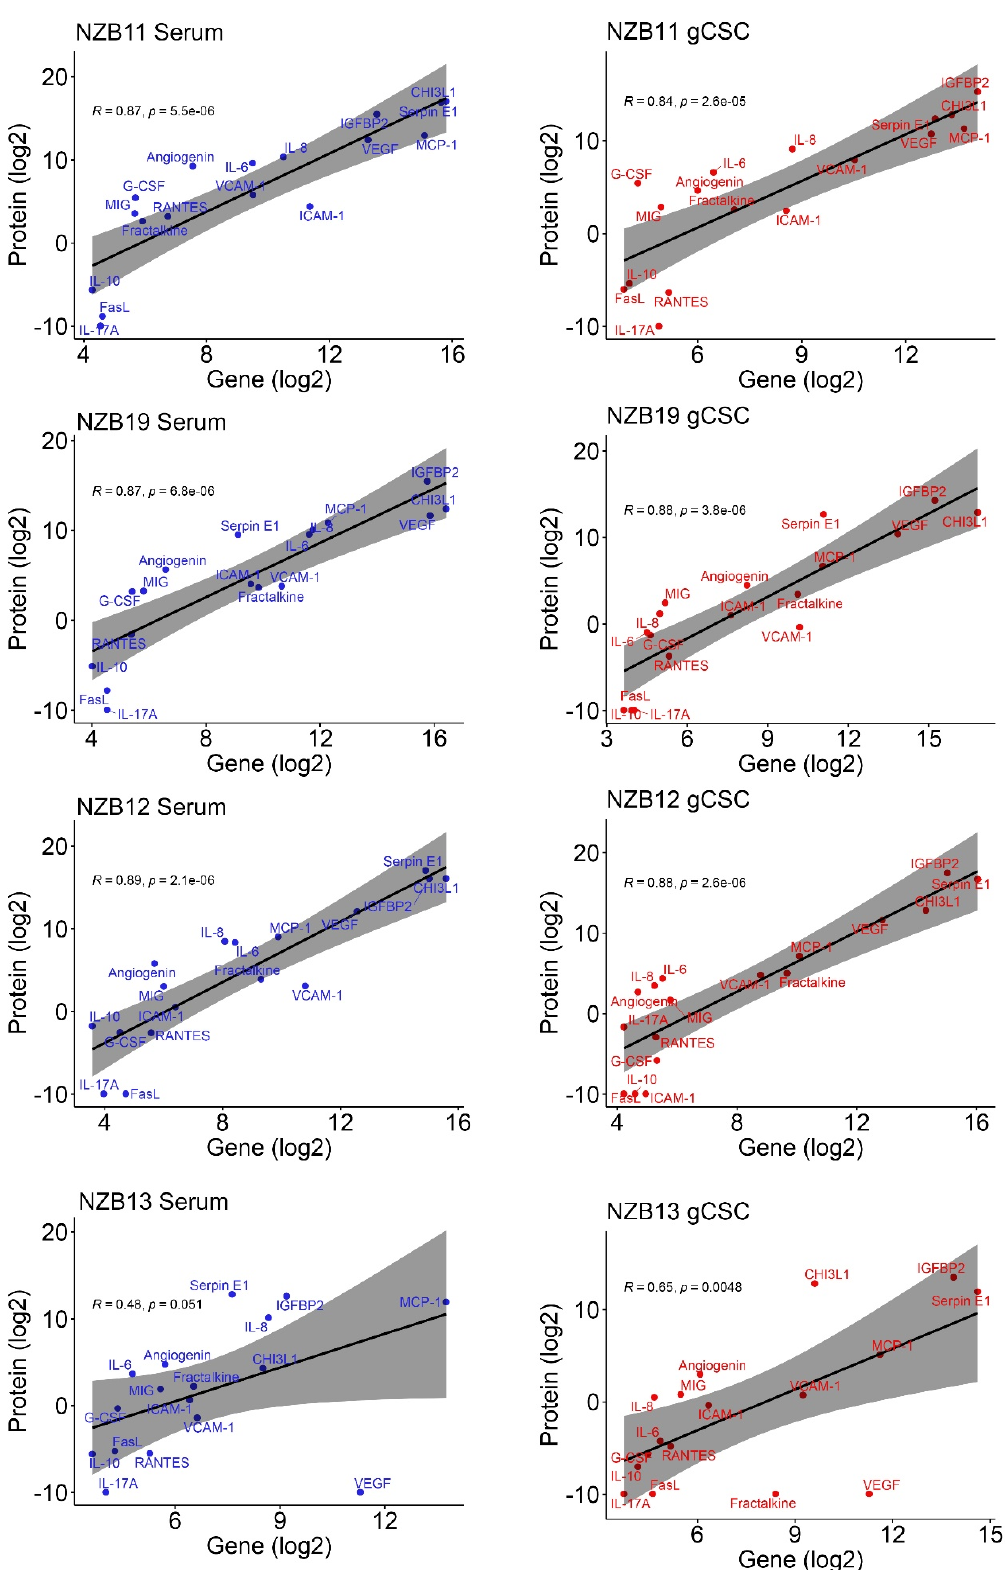
Figure 6. Secreted protein vs. gene expression correlation. Cytometric bead array and Luminex secreted protein concentrations, and NanoString mRNA count comparison in NZB11, NZB19, NZB12 and NZB13 serum and stem-like cell cultures. Coefficient of correlation ( R ) and related p values are shown ( p ). Red wording denotes gCSC data where blue denotes serum